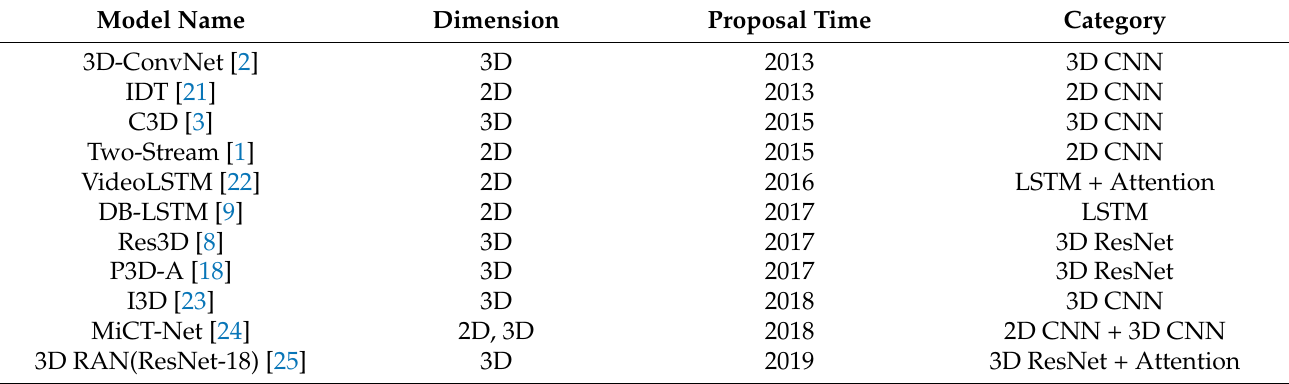
Table 3. Comparison model information